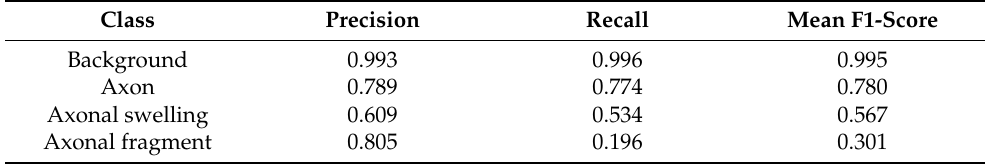
Table 1. Validation of the EntireAxon CNN performance for all four classes—‘background’, ‘axon’, ‘axonal swelling’, and ‘axonal fragment’—in previously unseen phase-contrast microscopic images.